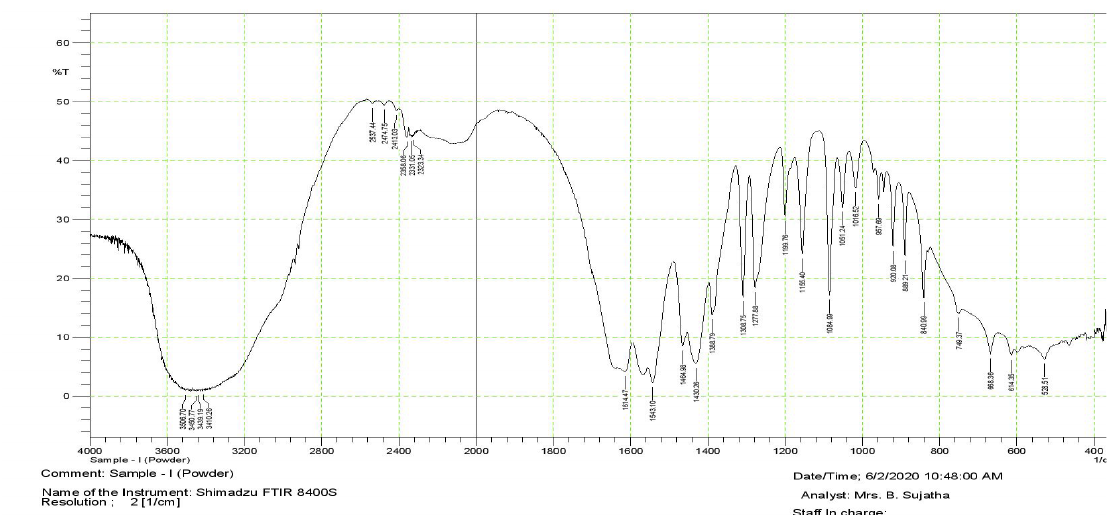
FIGURE 9 - Fourier-transform infrared spectrum of calcium oxalate